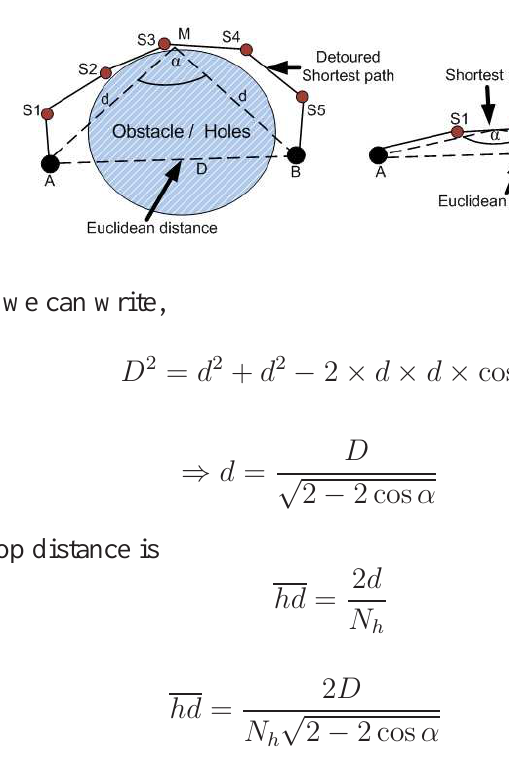
Figure 1. Packet transmission path between two anchors with obstacle and without